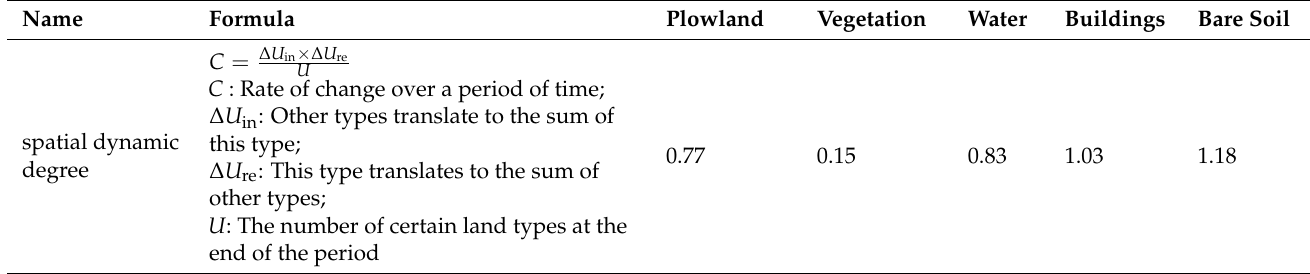
Table 5. Spatial dynamic degree of land change in the water source of Danjiangkou Reservoir in